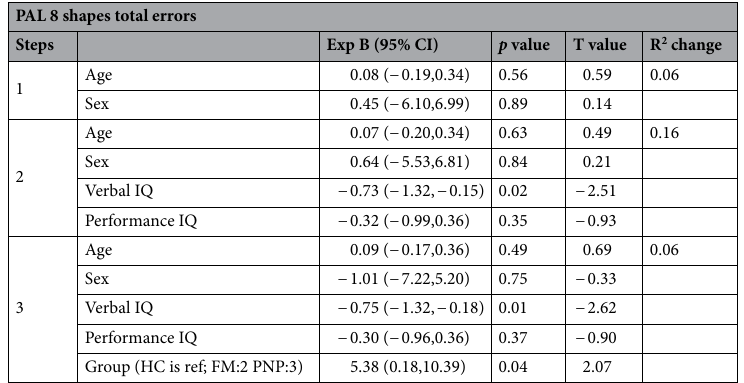
Table 2. The executive functioning outcome PAL analyzed using a multivariate linear regression model. The category and its association with this outcome were controlled for age, sex IQ and group categories (FM, PNP and HC). These variables were then added in steps to investigate r 2 change per step.